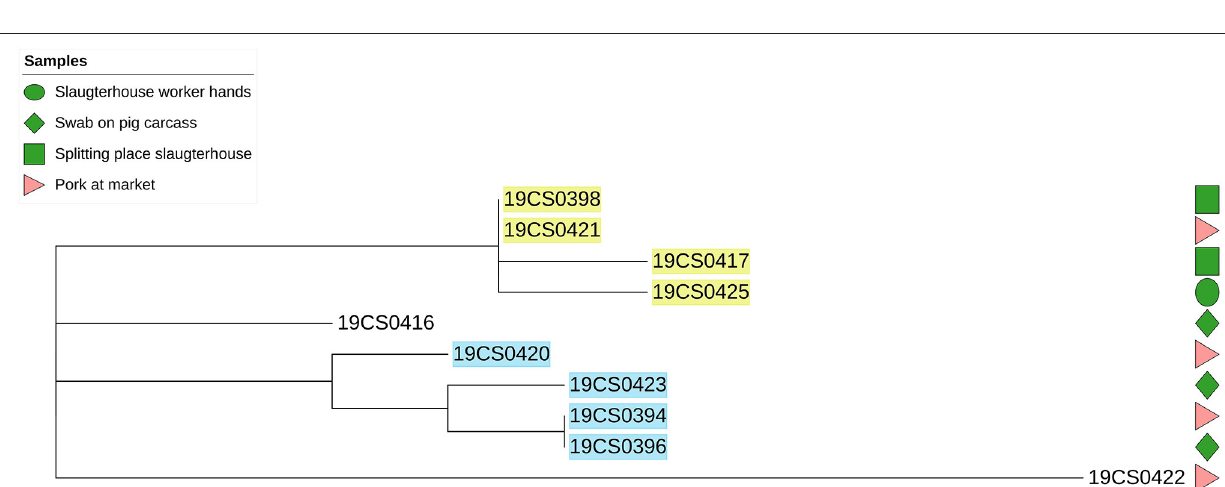
these clusters (yellow and gray highlight, Figure 2 ) contained strains taken in the slaughterhouses and